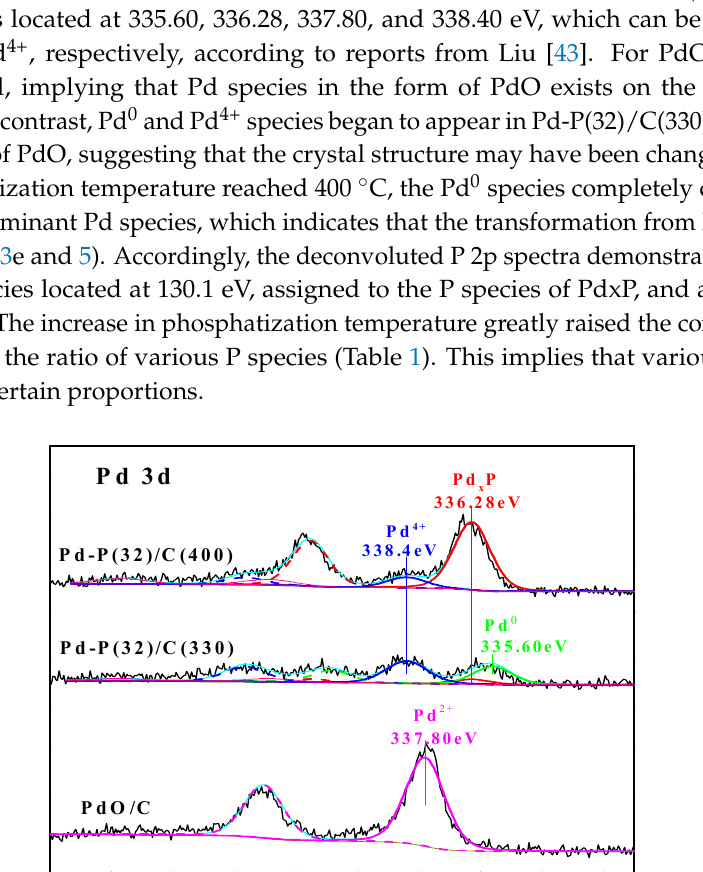
Figure 5. X-ray photoelectron spectroscopy (XPS) spectra of Pd 3d 5/2 for PdO/C, Pd-P(32)/C(330), and Pd-P(32)/C(400).